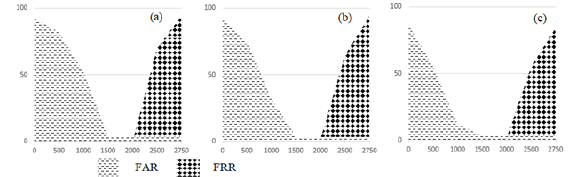
Figure 8. Result of classification using Support Vector Machine algorithm of 3 databases.